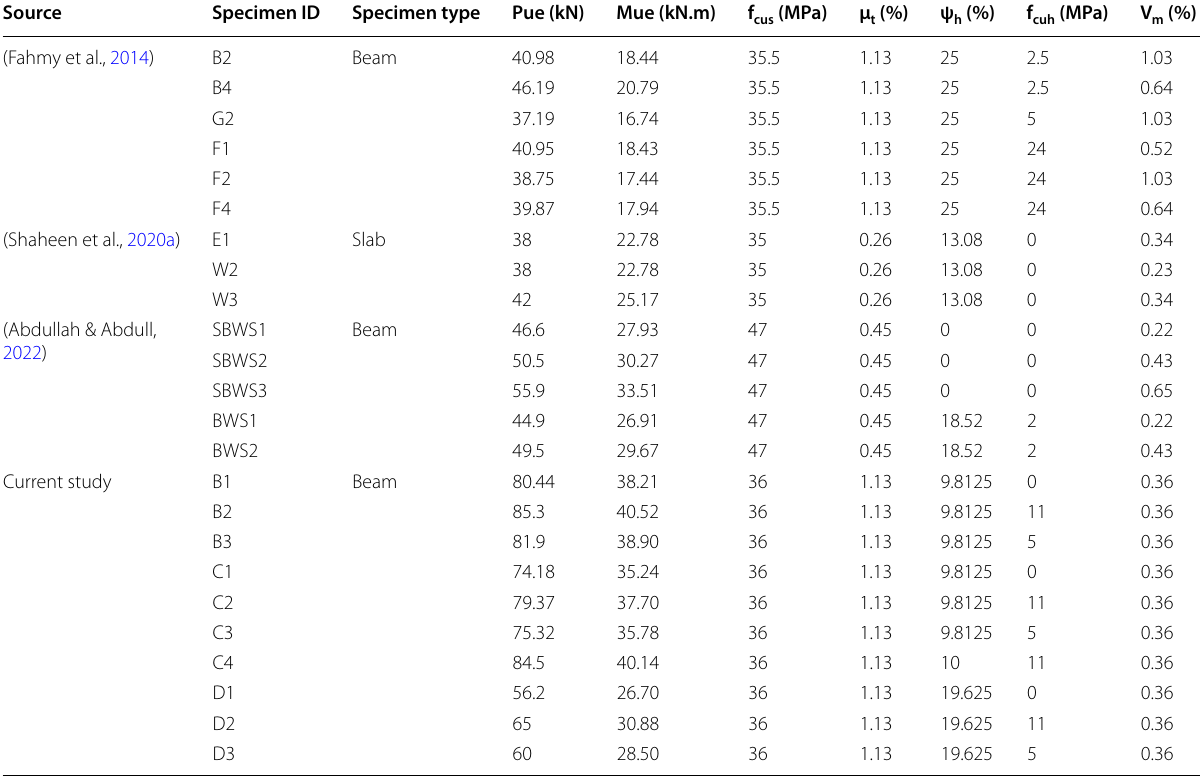
Table 10 Input data set required for predictive model Source Specimen